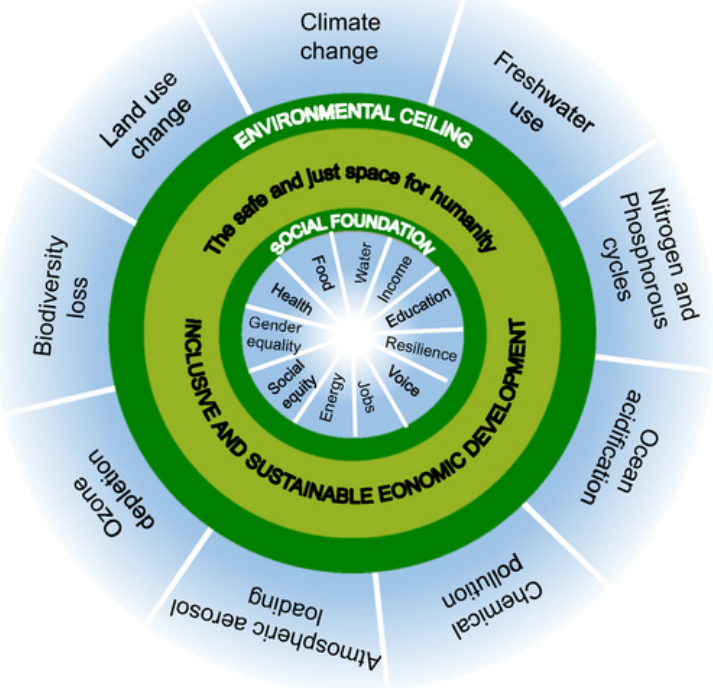
Figure 2. Doughnut economy (Raworth (2012)), which shows the safe operating space between the social foundation and the planetary boundaries.